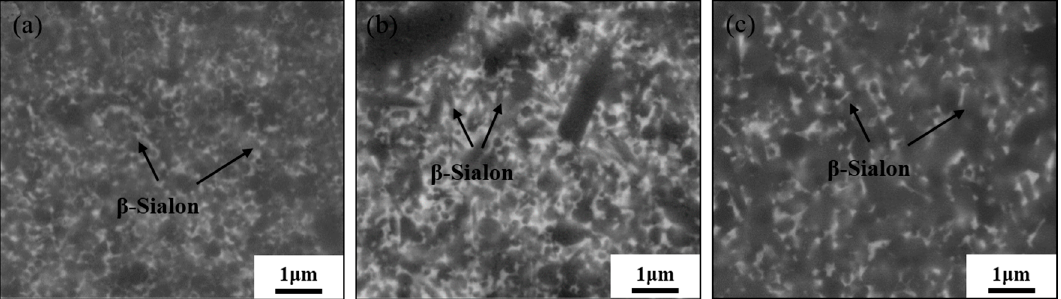
Figure 8. SEM micrographs of Yb-SiAlON glass solder in the seam zone at different bonding temperatures ( a ) 1550 °C, ( b ) 1600 °C, and ( c ) 1650 °C.